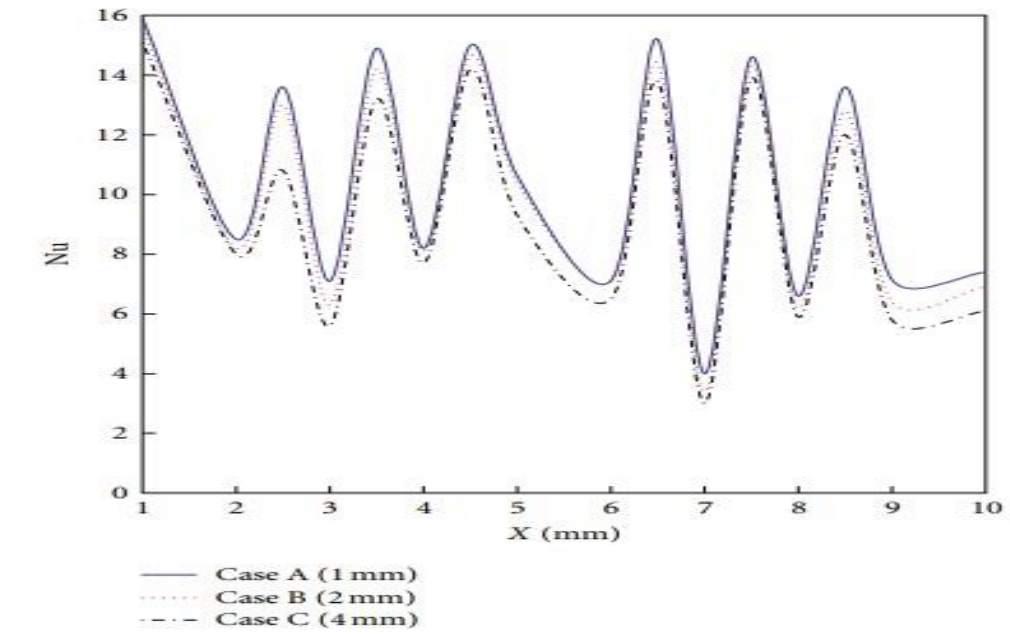
Figure 20: The deviation of Nu along the flow direction for variable fin pitch with uniform louver angle of 20 ◦ and Re = 500